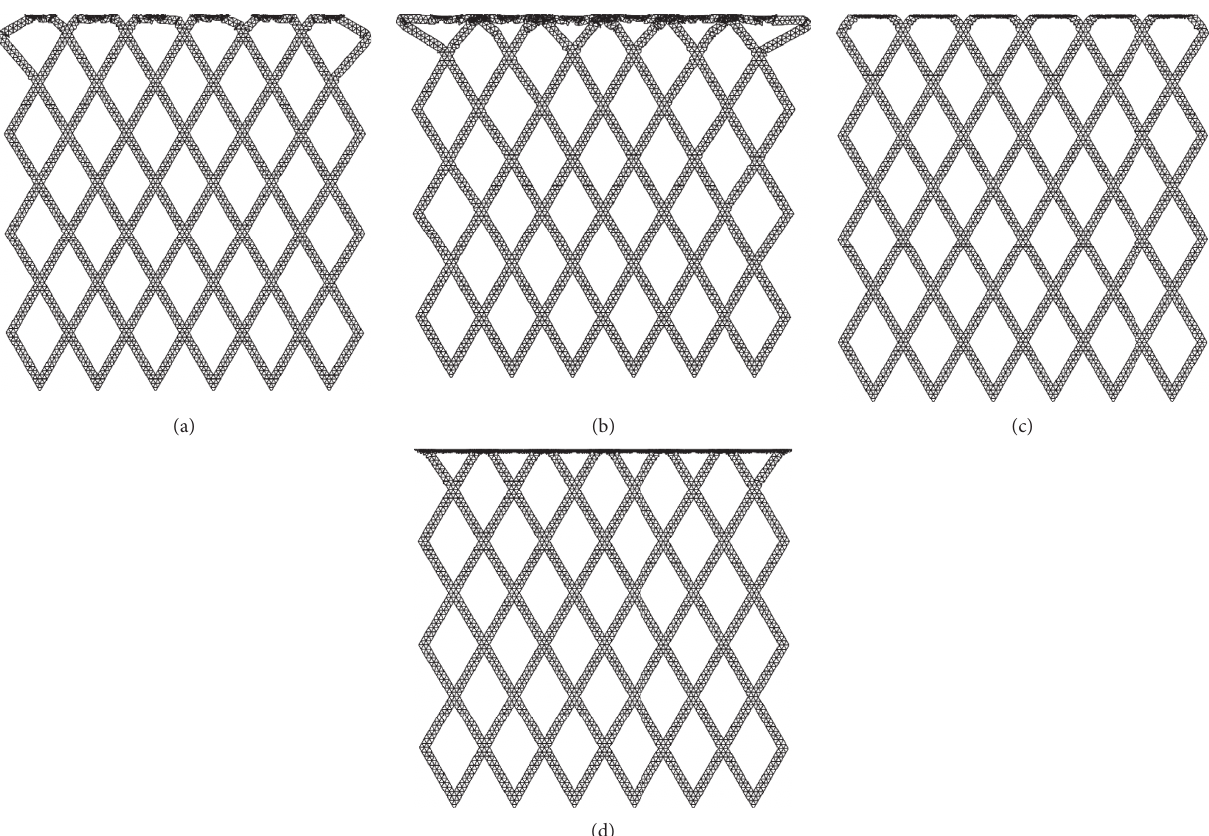
Figure 14: FE prediction of the dynamic collapse of the DHH in the z direction, ρ � 5% and N � 12. (a) V � 50m/s, ε � 10%. (b) V � 50m/s, ε � 17%. (c) V � 200m/s, ε � 10%. (d) V � 200m/s, ε �